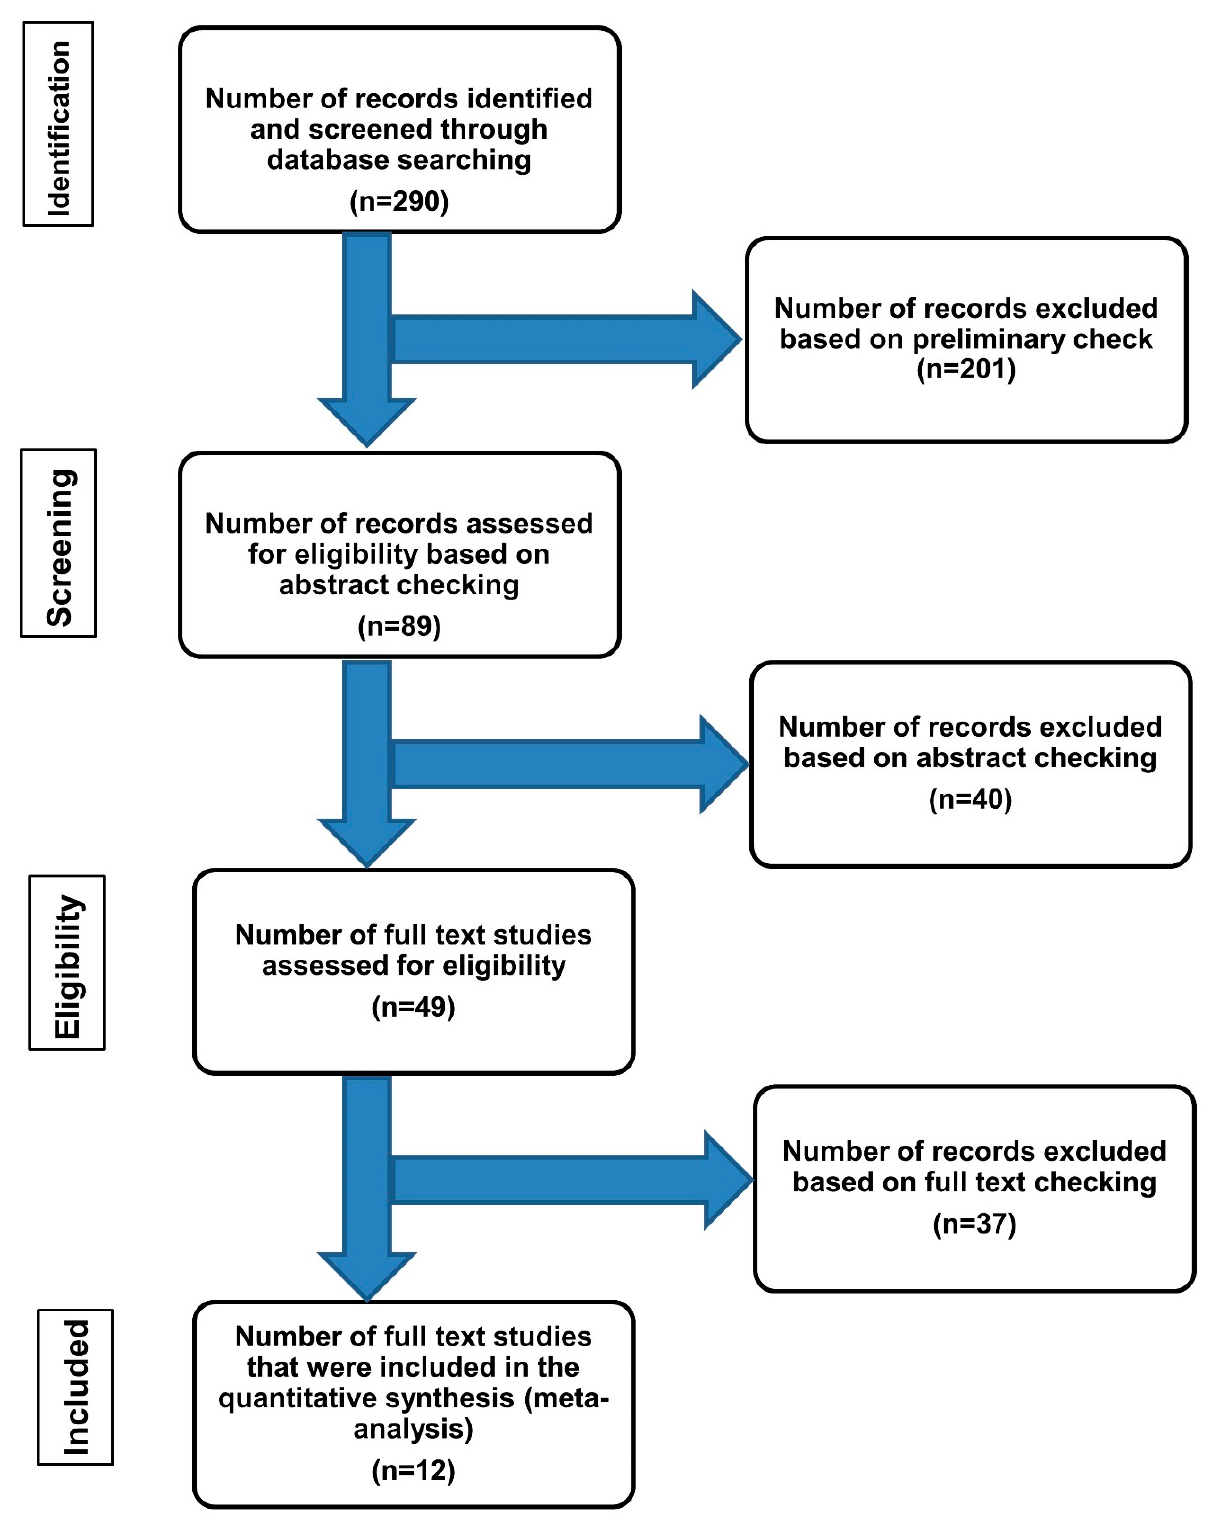
Figure 1. Flow chart of literature search and study selection for cases of dermatofibromas with aberrant expression of CD34.